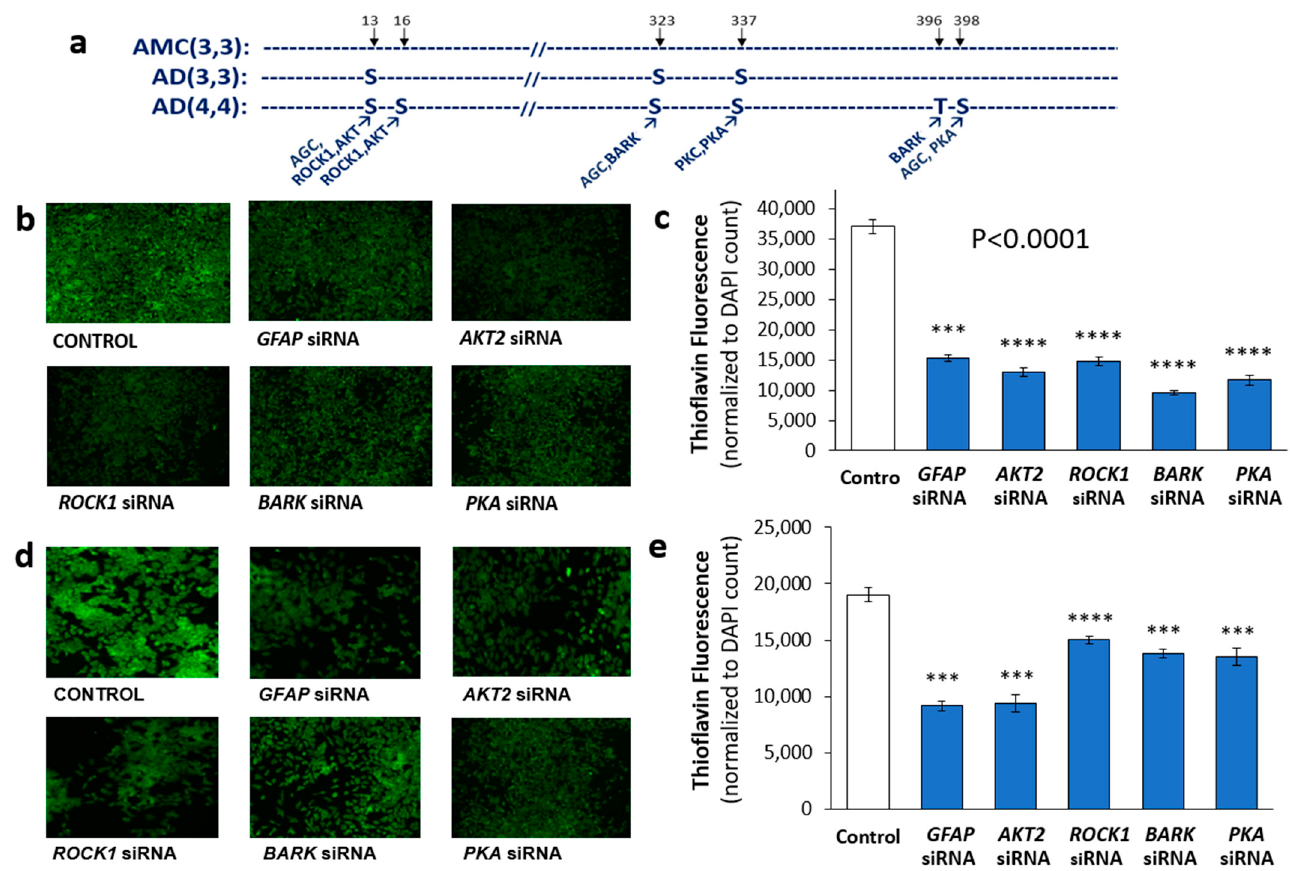
Figure 3. Effects on aggregation of RNAi knockdowns targeting GFAP or its putative kinases. ( a ) Observed GFAP phosphorylations in human hippocampal aggregates and their putative kinases. ( b ) Fluorescence images of Thioflavin T ‐ stained SH ‐ SY5Y ‐ APP Sw cells, after liposome ‐ mediated transfection with siRNA constructs targeting GFAP or its candidate kinases. ( c ) Histogram showing means ± SEM for Thioflavin T staining of aggregates as in ( b ). ( d ) T98G cells stained with Thioflavin T after transfection by siRNA constructs as shown. ( e ) Histogram of means ± SEM for Thioflavin T staining of aggregates as in panel ( d ). ( c , e ) Significance of differences between treated groups and controls according to heteroscedastic, two ‐ tailed t ‐ tests: *** p ≤ 0.0005; **** p ≤ 0.00005. Experiments were replicated 3–4 times, with consistent results.